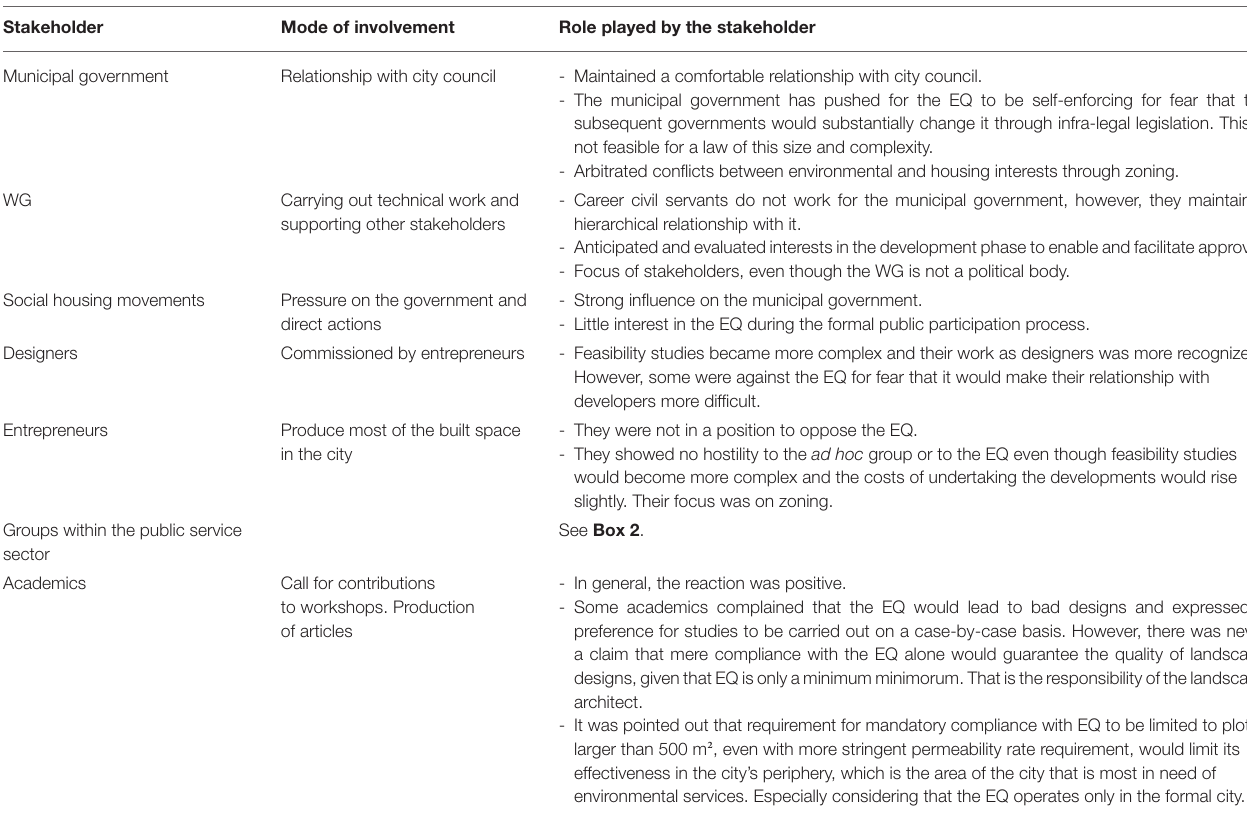
TABLE 4 | Stakeholder involvement in EQ development and